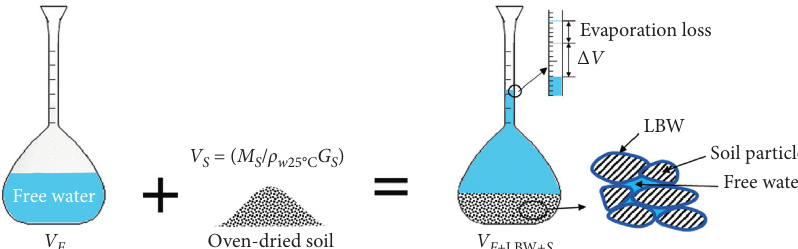
Figure 2: Procedure for measuring the LBW content. Note: Δ V is the reduction in volume of free water converted to loosely bound water; LBW is the loosely bound